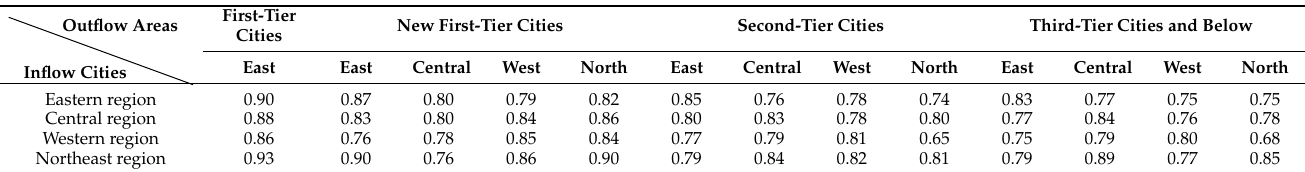
Table 5. Settlement intention of floating population in different cities, 2017 (%).